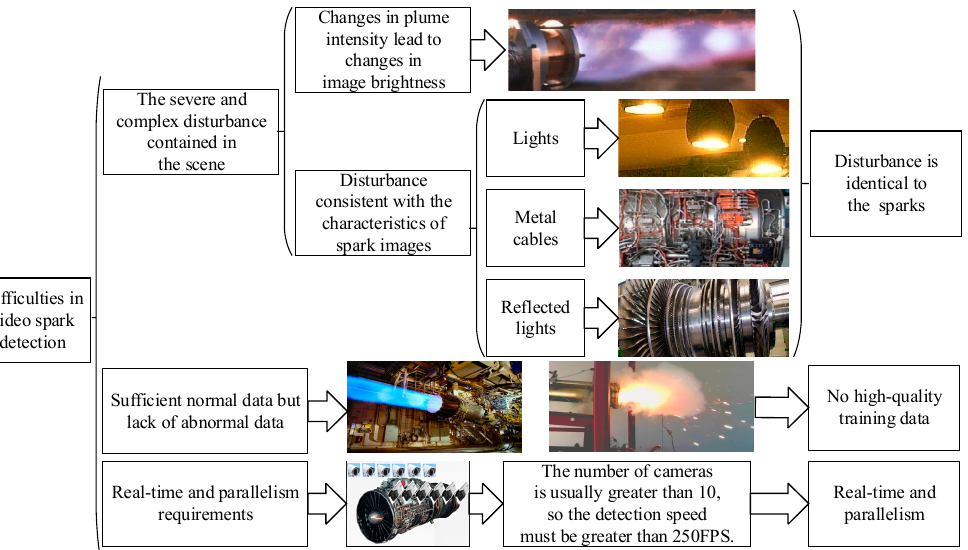
Figure 1. The three main difficulties in video spark intelligent